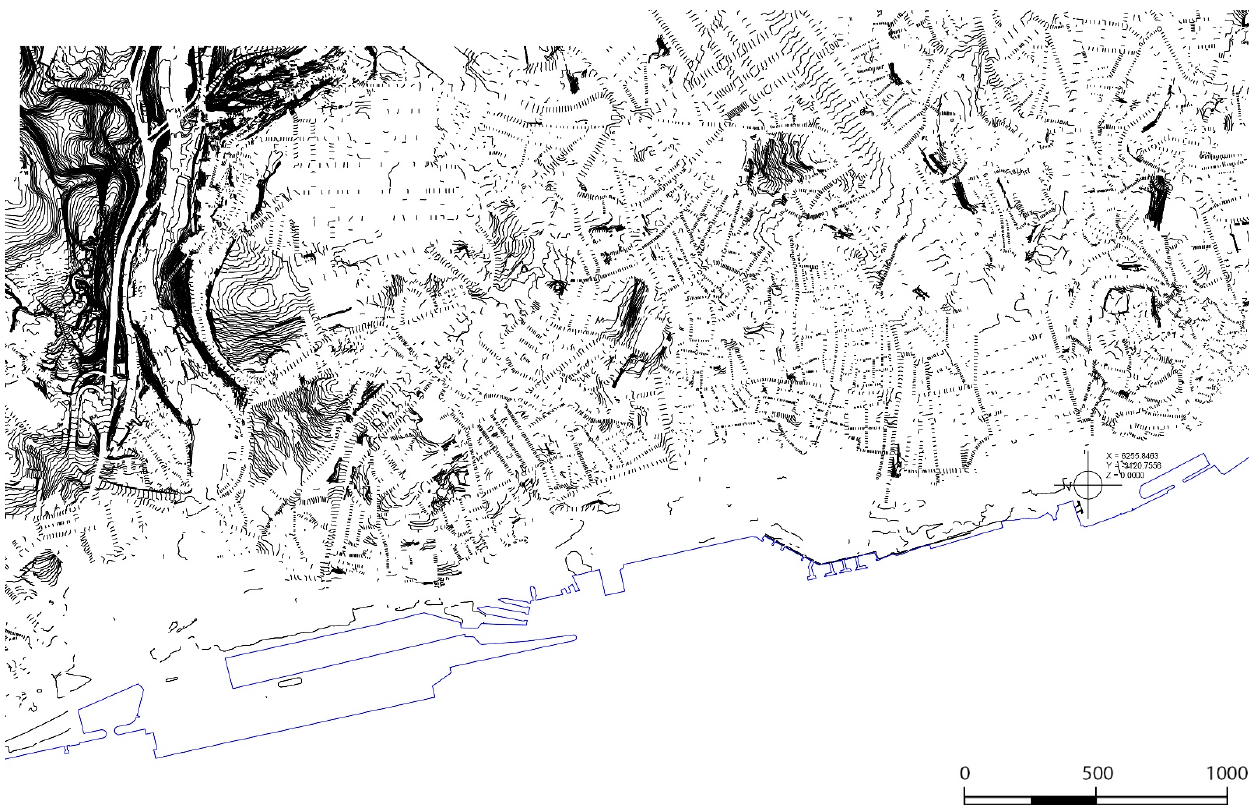
Figure 6. Contours on CAD, imported into Revit and used for the automatic creation of the terrain. The vertical distance between points in the cartography was 1 m, while the distance on x,y axes was variable between ~3 and ~70 m. This is due to the presence of buildings, or rather blocks that cover large areas. The area near the riverbank also has a low density of points and the detail of the terrain is not rich.